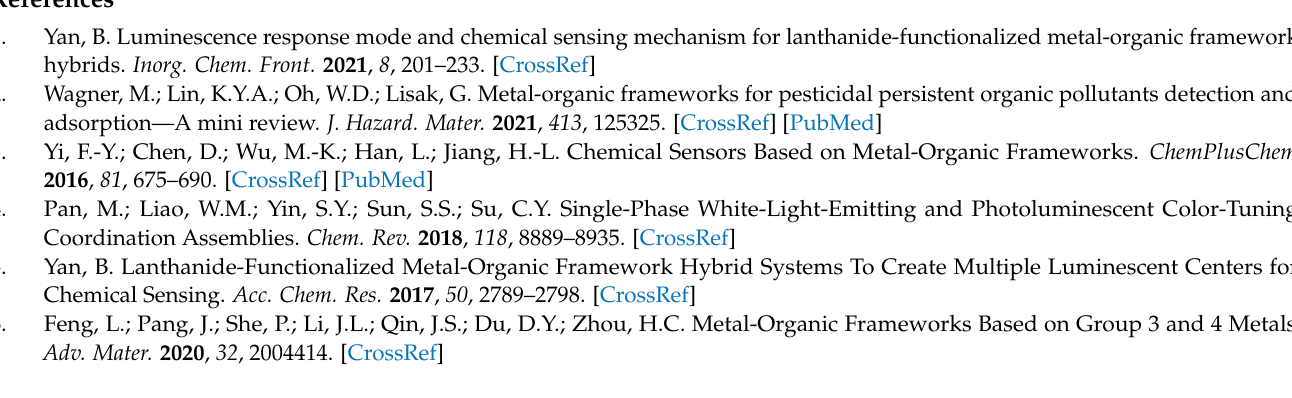
d 6 (v:v = 1:4) solution. Figure S4: FT-IR spectra of (a) the ligand H 2 BPD-4F4TS and (b) as-made ZnBPD-4F4TS ; (c) ZnBPD-4F4TS after exposed to air for 21 days; (d) ZnBPD-4F4TS after soak- ing in boiling water for 30 h. Figure S5: Thermogravimetric plots of activated ZnBPD-4F4TS . Figure S6: PXRD patterns of (a) simulation from single crystal of ZnBPD-4F4TS ; (b) as-synthesized NH 4 Br@ZnBPD-4F4TS ; (c) NH 4 Br@ZnBPD-4F4TS after proton conduction test. Figure S7: Room Figure S8: PXRD patterns of ZnBPD-4F4TS after immersion in various metal ion solutiona. Figure S9: Proton conductivities of ZnBPD-4F4TS and NH4Br@ZnBPD-4F4TS at different tem- peratures (from 40 ◦ C to 80 ◦ C) and 90% RH. Figure S10: PXRD patterns of (a) simulation from single crystal of ZnBPD-4F4TS ; (b) as-synthesized ZnBPD-4F4TS ; (c) ZnBPD-4F4TS after proton conduction test. Table S1: Crystallographic refinement parameters and results of ZnBPD-4F4TS